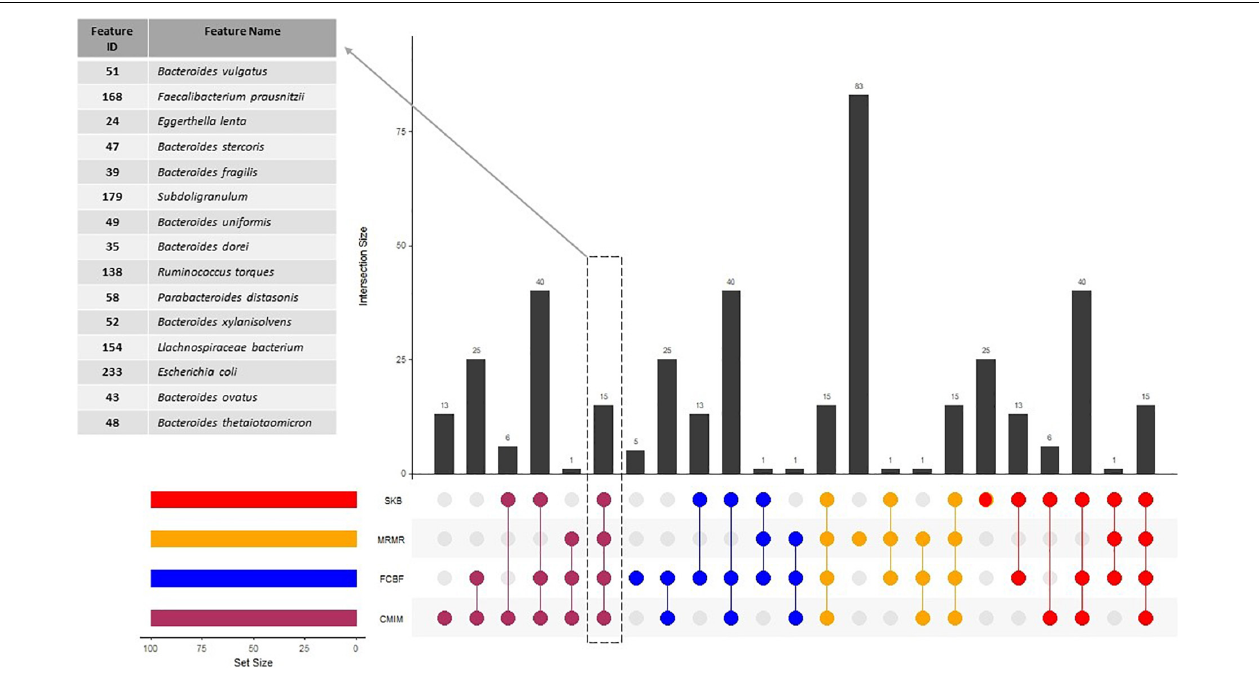
FIGURE 2 | Numbers of features, which are selected by different feature selection algorithms. The commonalities between the selected features by different methods are also illustrated.